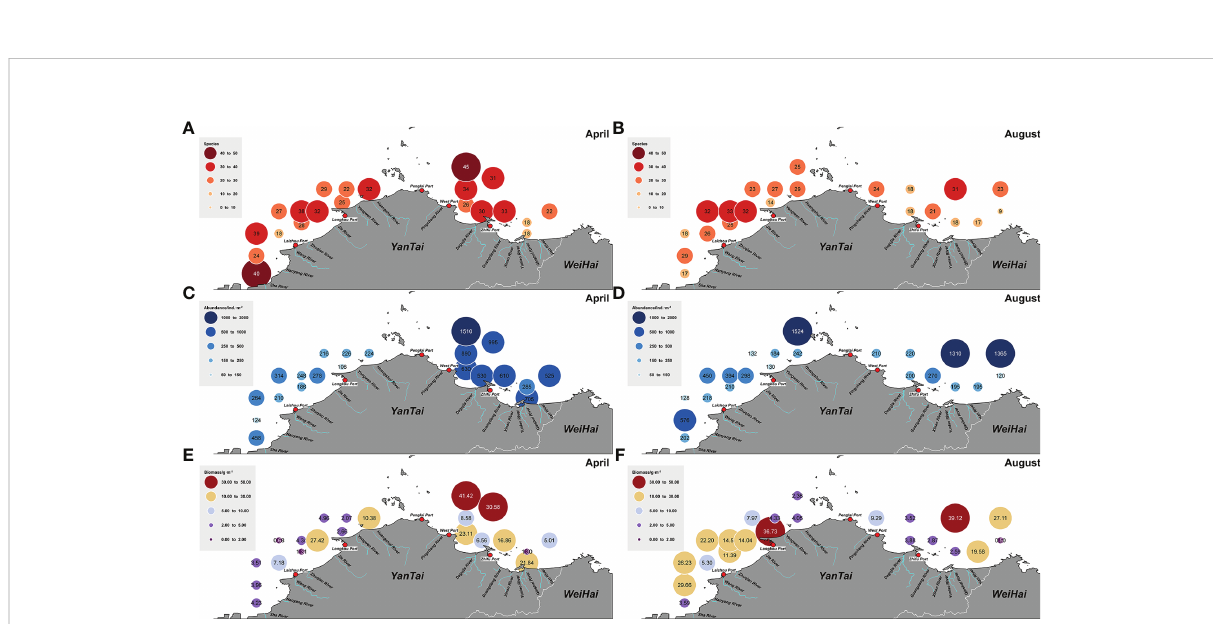
FIGURE 3 Spatial distribution of (A, B) species numbers, (C, D) abundance, and (E, F) biomass of macrobenthos in the northern sea areas off Yantai, China, in April and August of